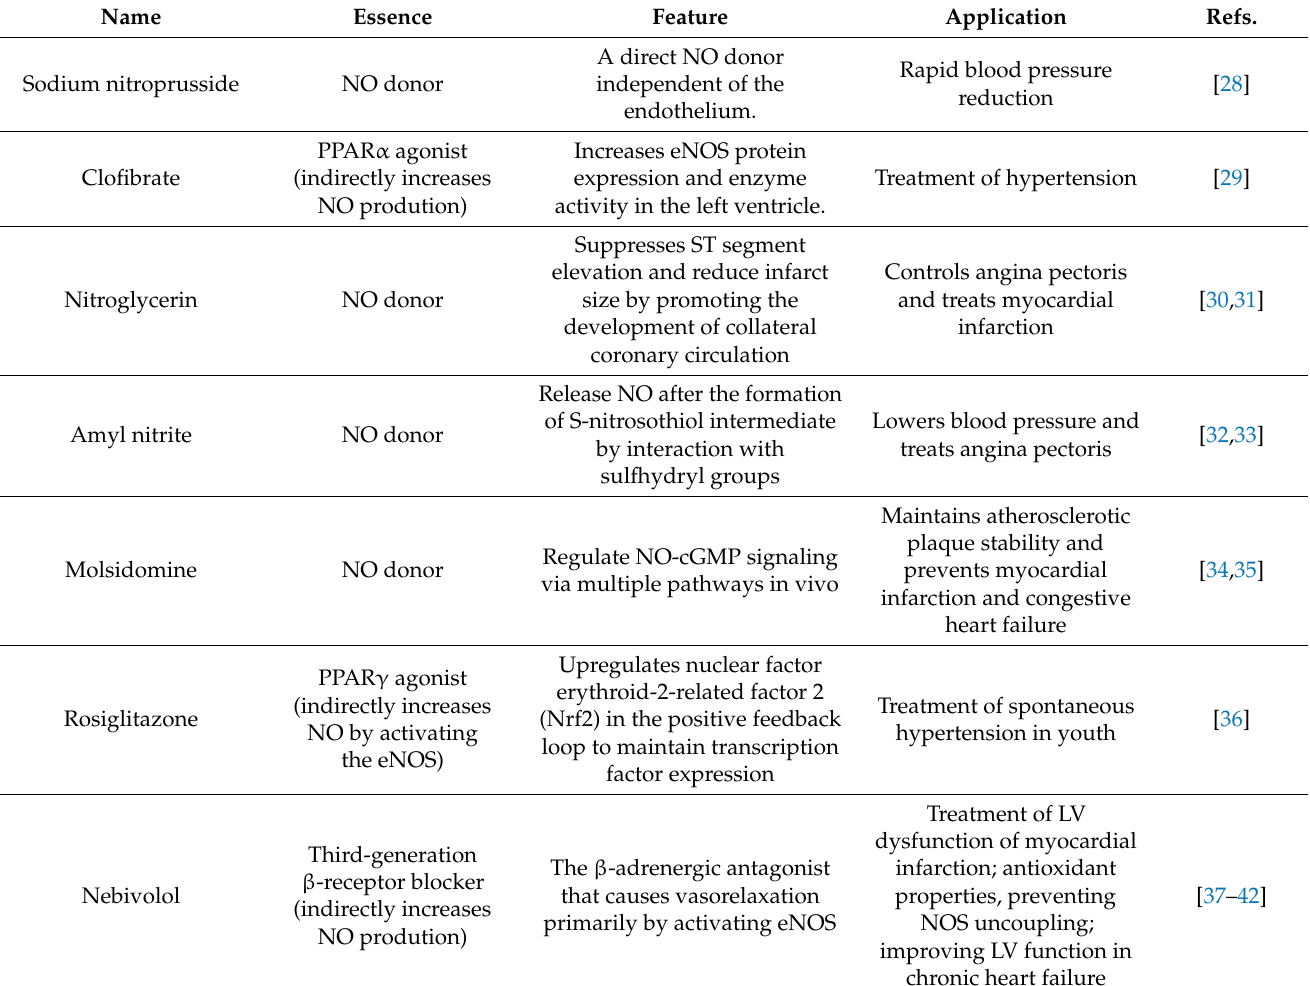
Table 1. Summary of the NO donors or NO-related drugs for the treatments of